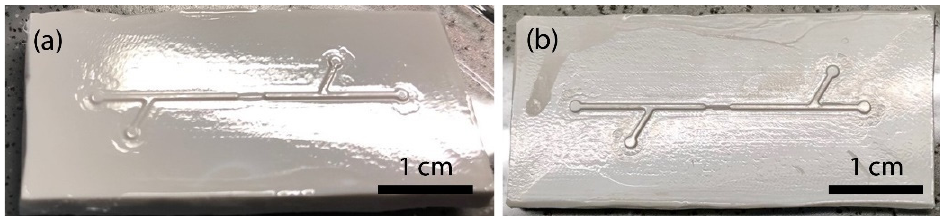
Figure 22. Acetone dipping polished casting mold fabricated through milling on ABS. ( a ) Mold after acetone polishing and air drying. ( b ) Mold after acetone polishing and pressurized gas drying.